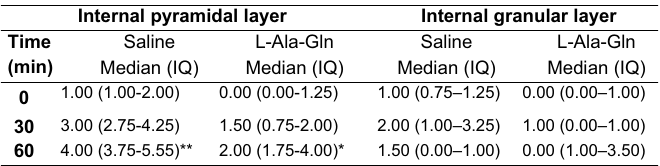
TABLE 3 - Degree of pyknosis in the internal pyramidal layer and the internal granular layer of the cerebral cortex for Group S (saline solution) and Group G (L-alanyl-L-glutamine) before (T ) and after 30 0 minutes (T ) and 60 minutes (T ) of 30 60